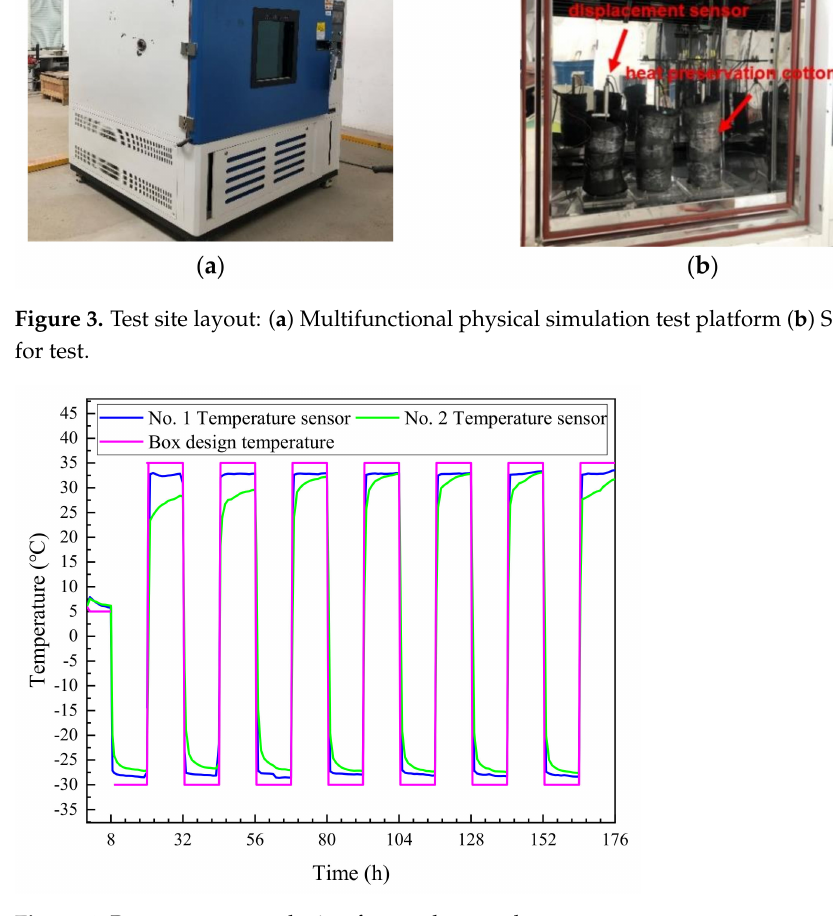
Figure 4. Box temperature during freeze–thaw cycle.